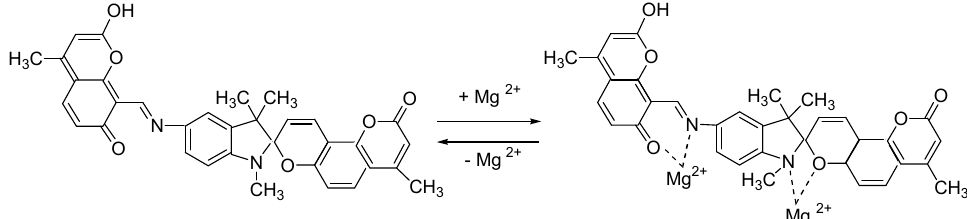
Scheme 14. Assumed type of complex formation for the tautomeric form A T of compound 1 with